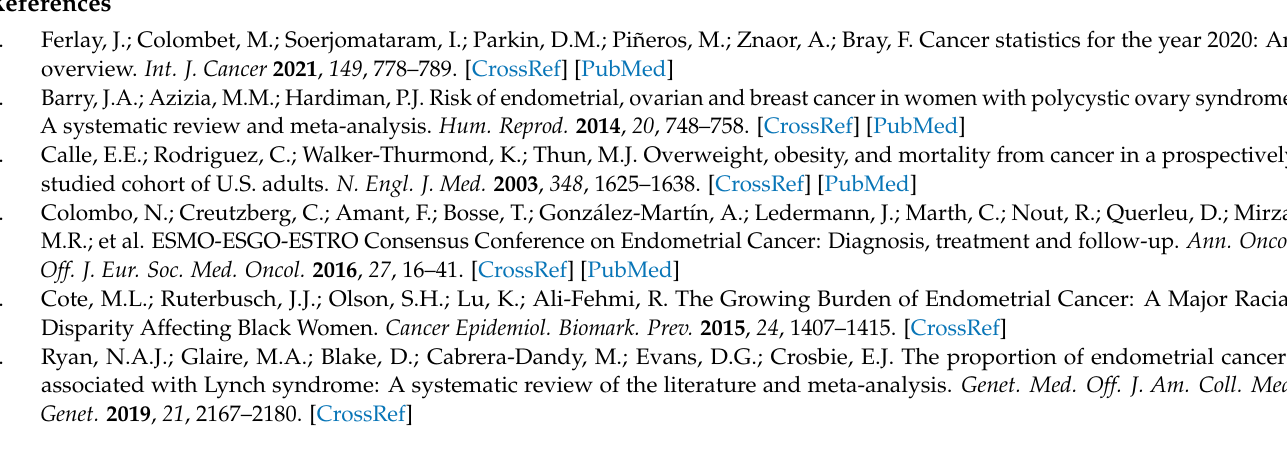
Table S1: Patients